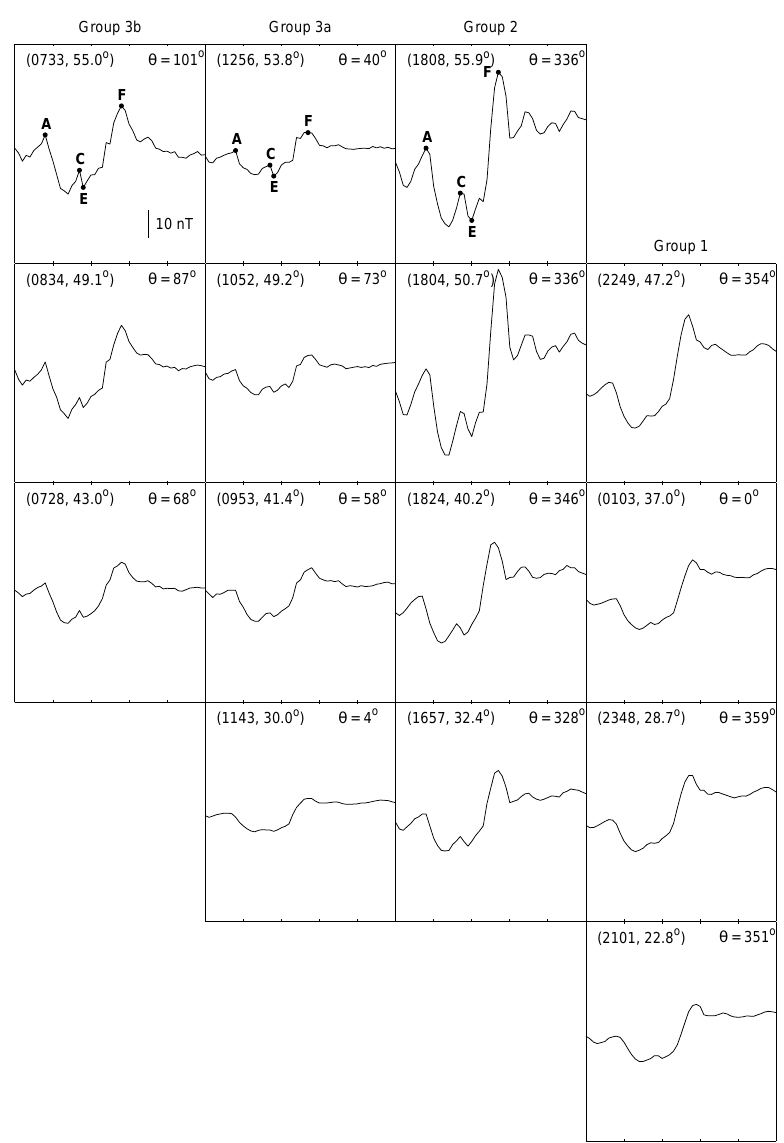
Fig. 7. A summary of the characteristics of the ground response along the M1 axis.